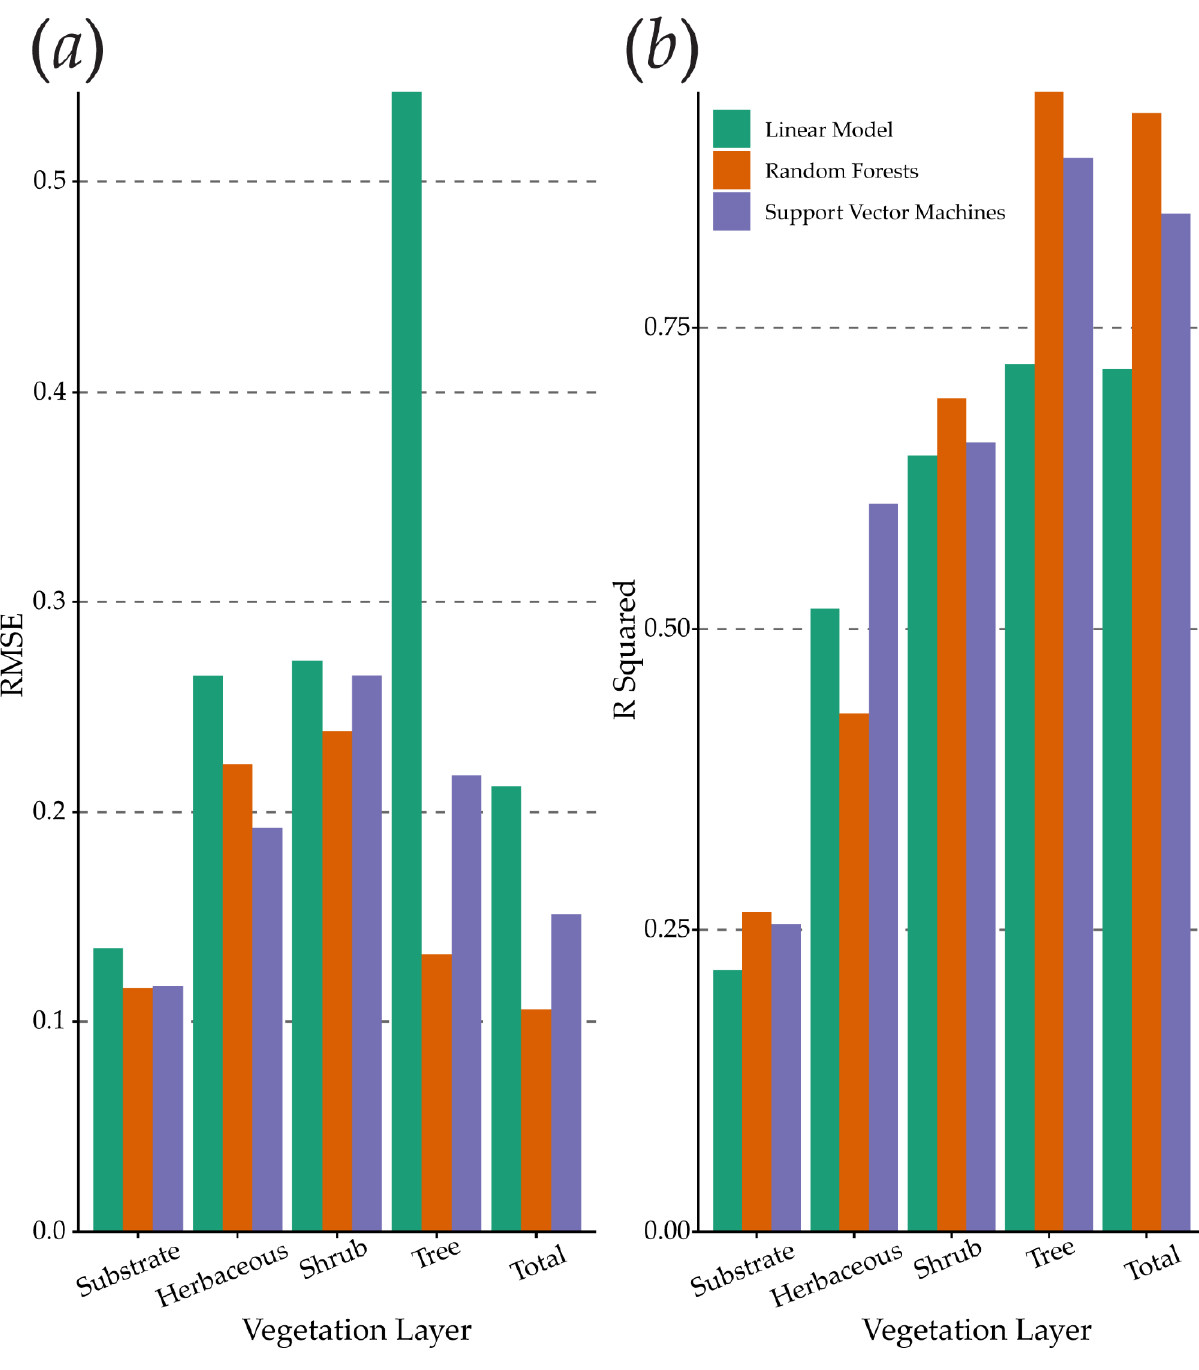
Figure 5. Comparison of different algorithms for predicting total plot CBI and CBI by strata using RMSE ( a ) and R-squared ( b ).